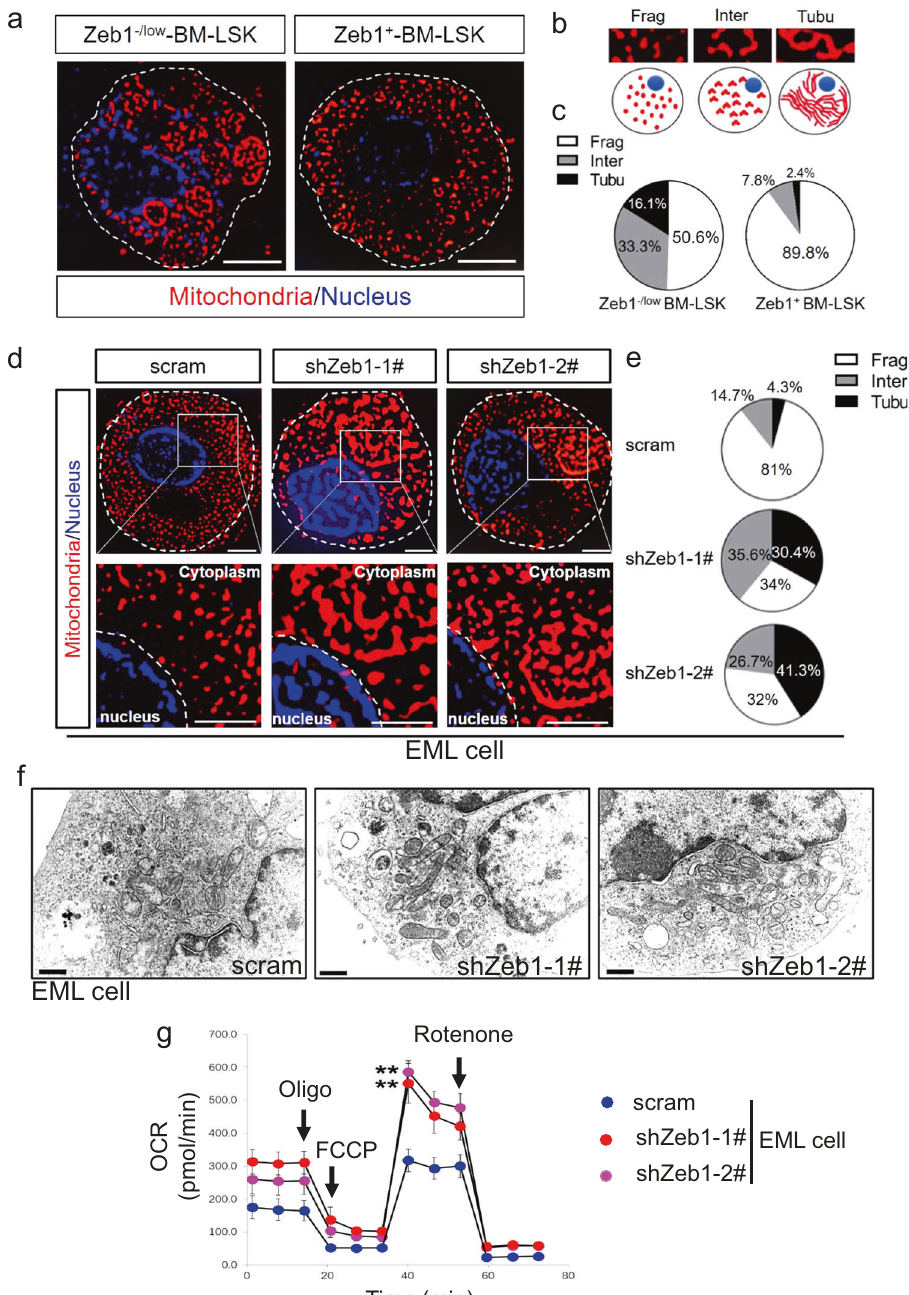
Fig. 6 Zeb1 confers fragmented mitochondria to EML cells. a Representative IF images of Mito-Tracker-Red in BM Zeb1 − /low and Zeb1 + -LSKs from Zeb1-tdTomato reporter mice. All images were captured using a SIM microscope. The nucleus was counterstained with Hoechst dye. Scale bar = 3 μ m. b Typical structures of fragmented (Frag) and tubulated (Tubu) and intermediate (Inter) mitochondria. c Quanti fi cations of Frag, Tubu and Inter mitochondria in BM Zeb1 − /low and Zeb1 + -LSKs. d IF images of Mito-Tracker-Red in EML-scramble and shZeb1-1# and shZeb1- 2# cells. All images were captured using a SIM microscope. The nucleus was counterstained with Hoechst dye. Scale bar = 3 μ m. Boxed areas at a higher magni fi cation showing detailed mitochondrial structures. e Quanti fi cations of Frag, Tubu and Inter mitochondria in EML-scramble and shZeb1-1# and shZeb1-2#. f Transmission electron microscopic (TEM) images showing the mitochondrial morphology of EML-scramble, shZeb1-1# and shZeb1-2# cells. Scale bar = 0.2 μ m. g Seahorse experiment showing the Oxygen consumption rate (OCR) of EML-scramble and shZeb1-1# and shZeb1-2# EML cells. ** p <